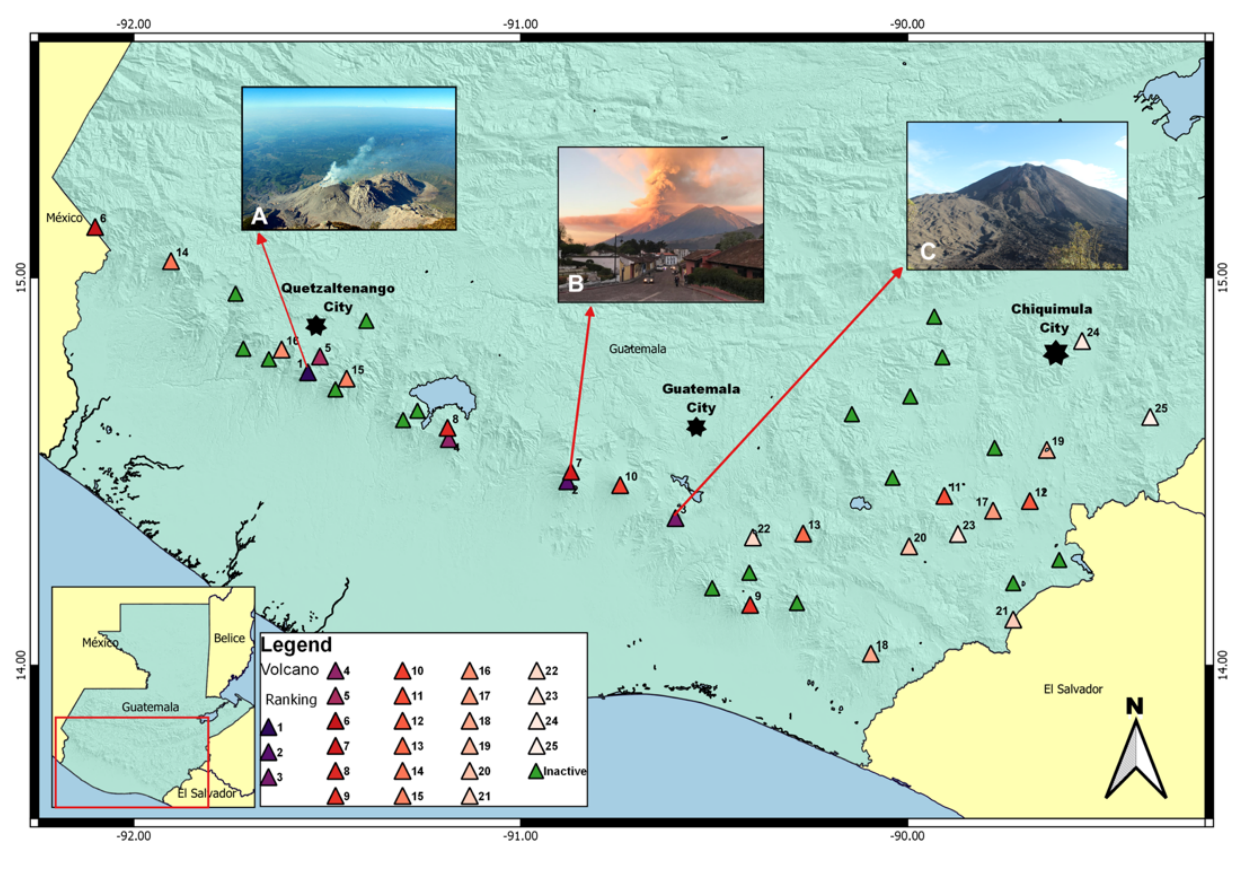
Figure 1: Map of the Guatemalan volcanoes. A total of 43 volcanoes are marked, with the currently (18) inactive volcanoes shown in green, the (25) active and potentially active included in the Relative Threat Ranking are shown in different colors in order to identify their positions in the ranking. The three continuously erupting volcanoes are: Santa Maria/Santiaguito, Fuego, and Pacaya volcanoes (shown as [A], [B] and [C]